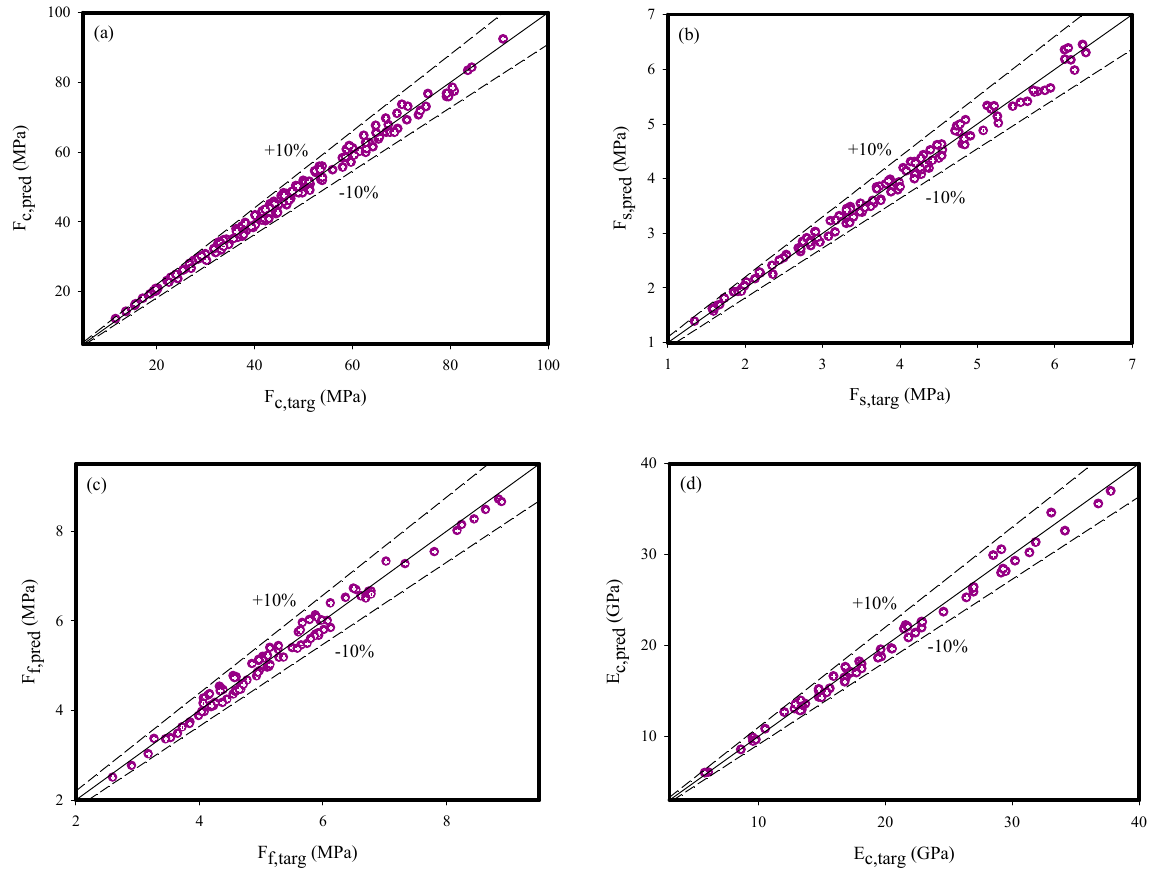
Figure 13. Target and prediction values for each